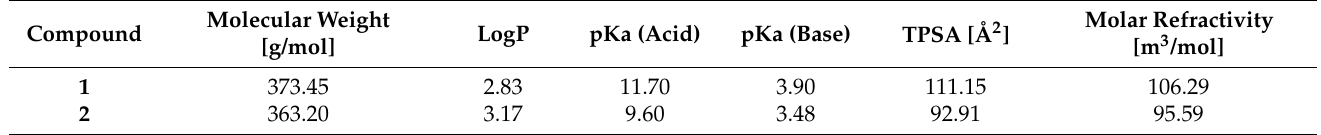
Table 5. Basic physicochemical properties of the two compounds.